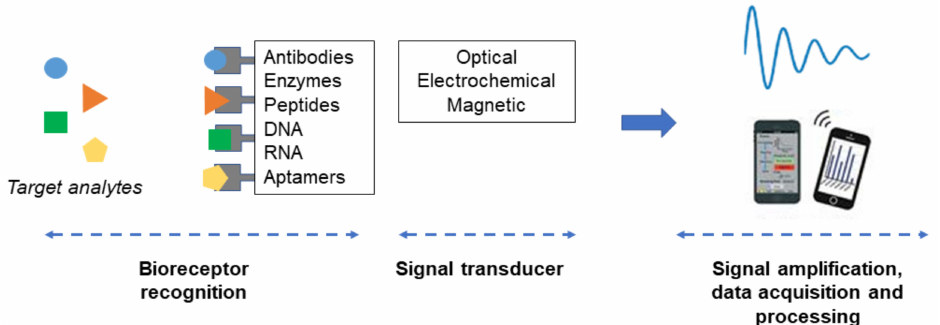
Figure 1. Schematic diagram showing biosensor components: bioreceptor recognition, transducer, and data